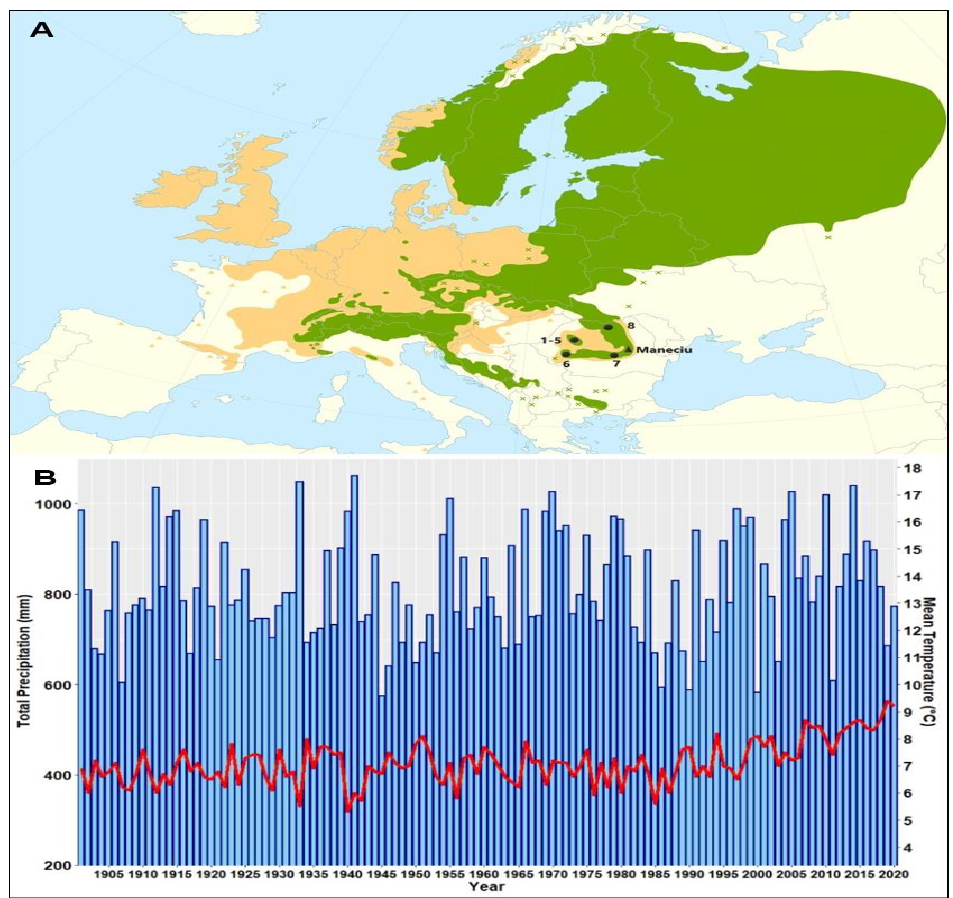
Figure 1. Location of the M ă neciu field trial and provenances origins on the Norway spruce distri- bution map [35]. Natural species distribution is denoted using green and artificial using brown ( A ). Regional climate trends in the mean annual temperature (red) and total precipitation (blue) for the M ă neciu trial during the 20th century computed using CRU gridded data ( B ).